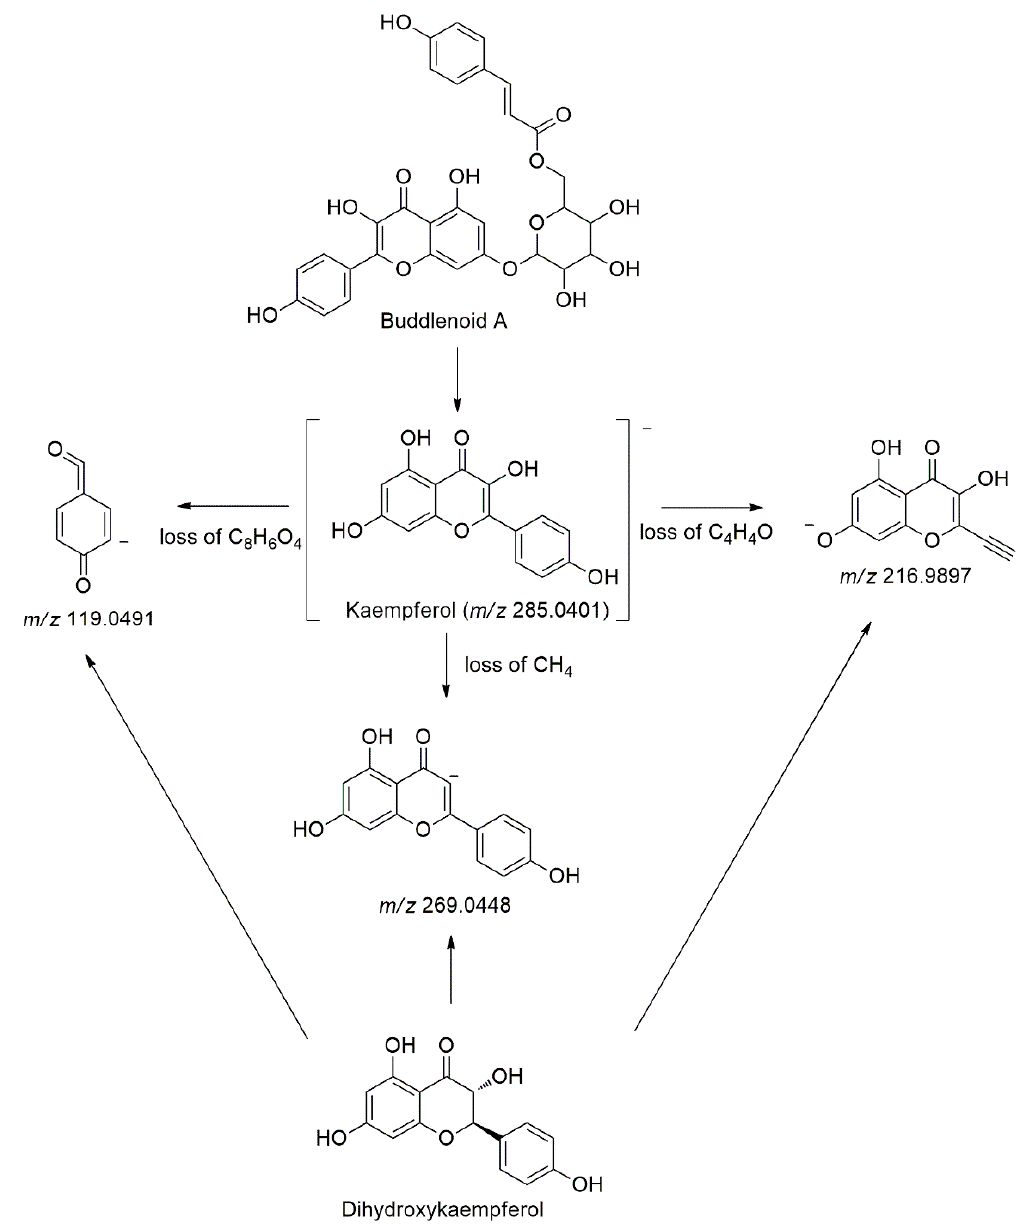
Figure 3. The main fragmentation pathways of the kaempferol derivatives.